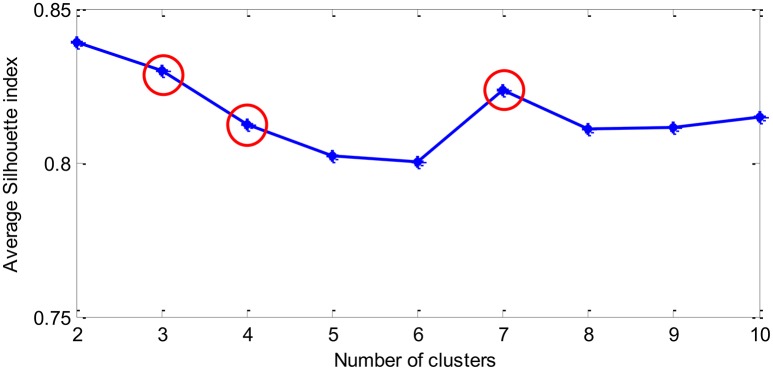
The average Silhouette index vs. the number of clusters (K) assumed in K-means clustering algorithm.